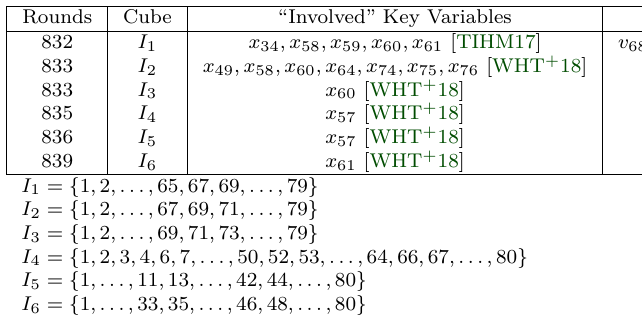
Table 1: Results on Trivium variants with up to 839